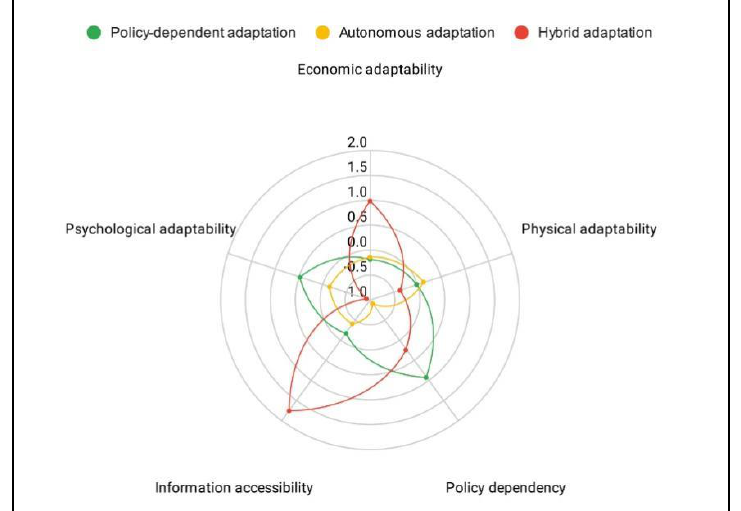
Figure 5. Average dimension scores of the three landslide adaptation types.